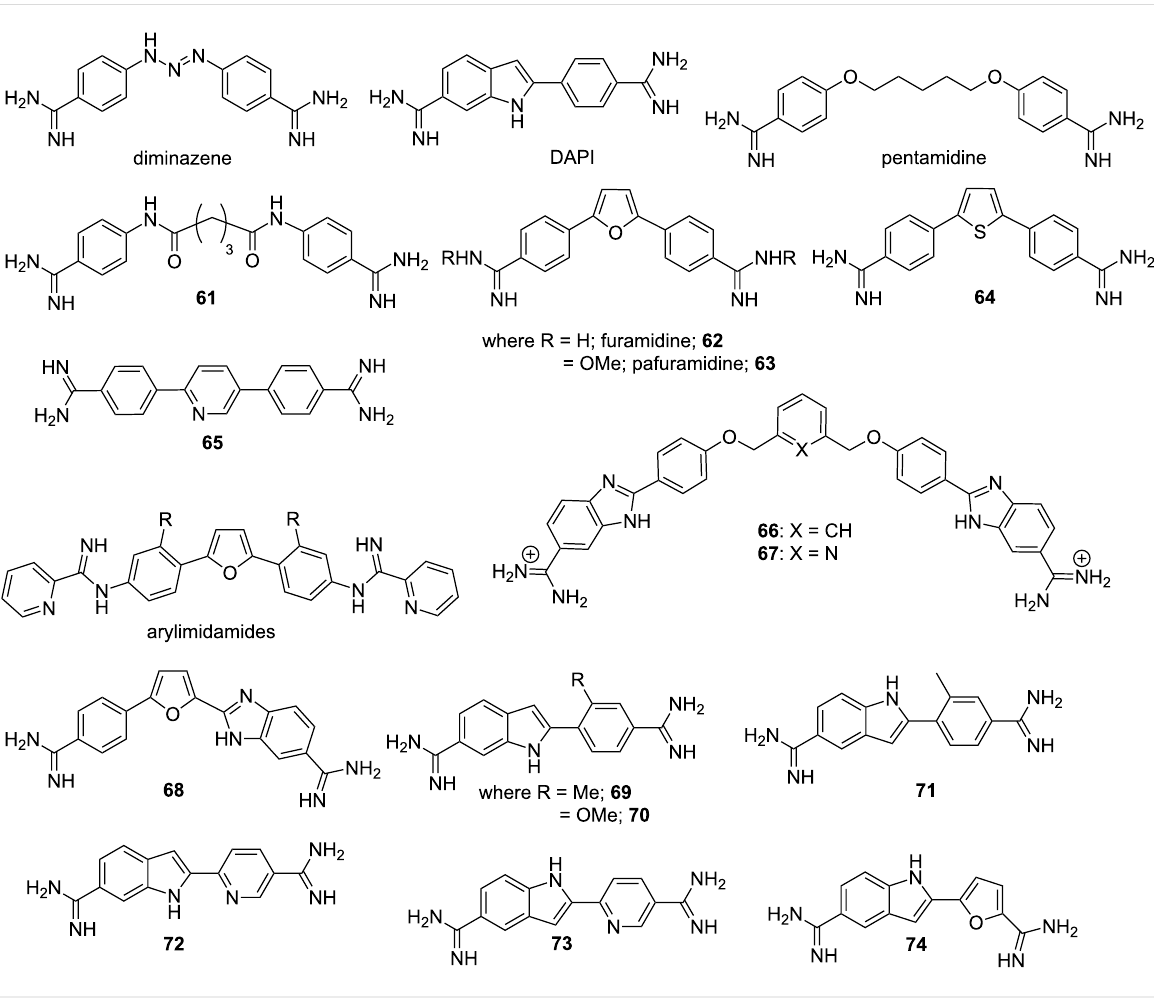
Figure 11: Chemical structures of bisamidines such as diminazene, DAPI, pentamidine and their synthetic structural analogs by varying substitutions, linkers and introducing